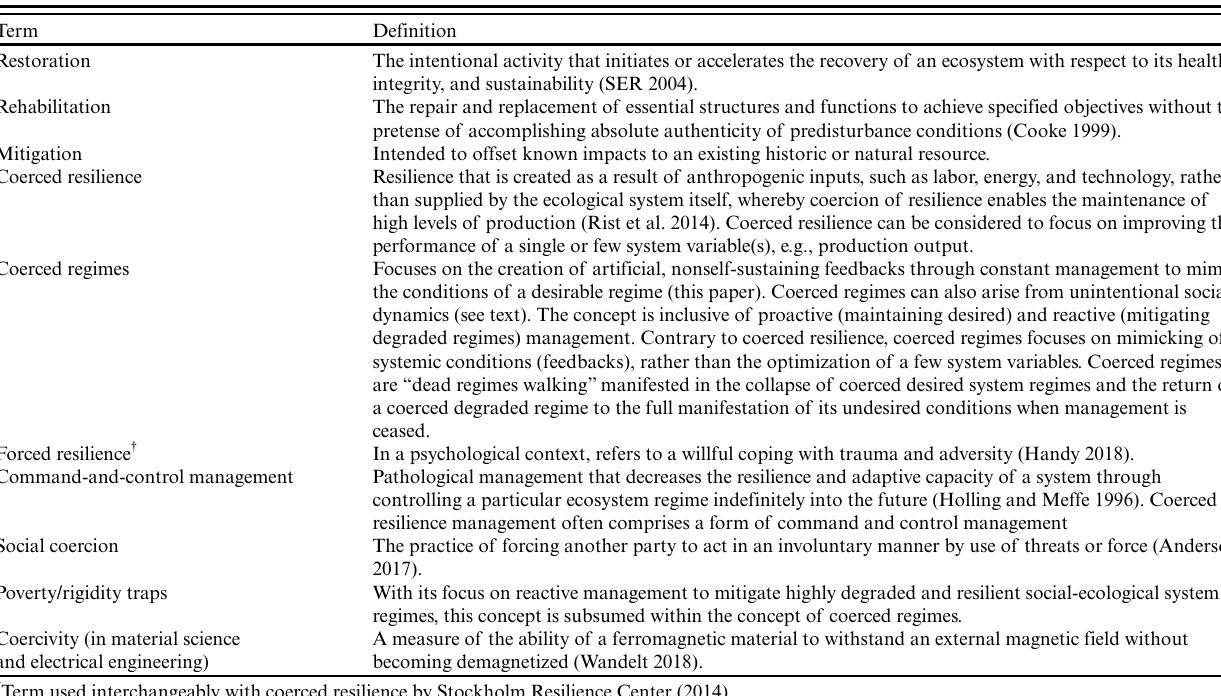
Table 1 . Definitions of coercion terms that are used across different scientific fields.